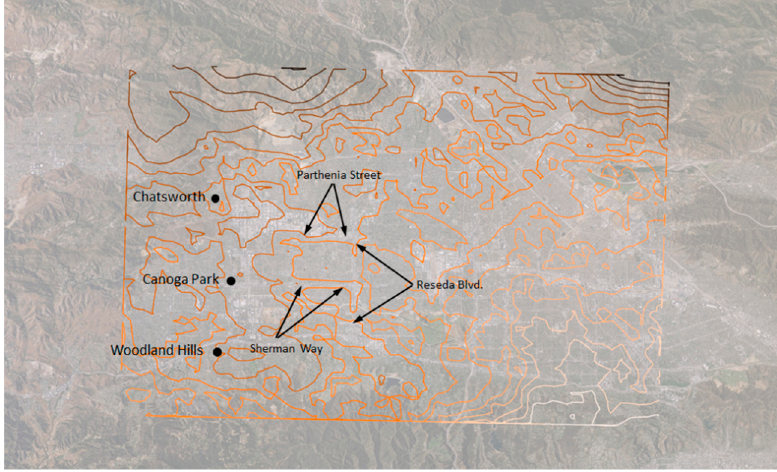
Figure 5. Total DH for interval 1 in the San Fernando Valley 500-m domain. The unlabeled contours are only meant to show the spatial pattern of the temperature field.